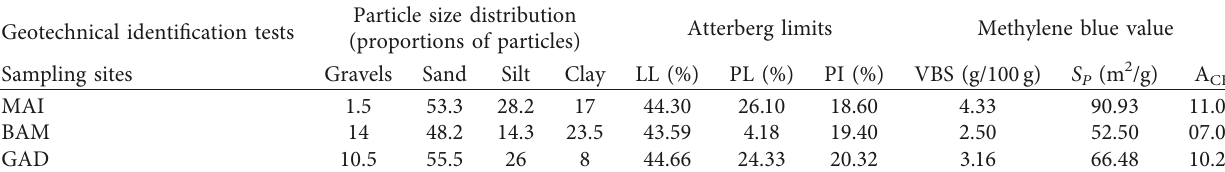
Table 1: Results of the geotechnical identification tests.